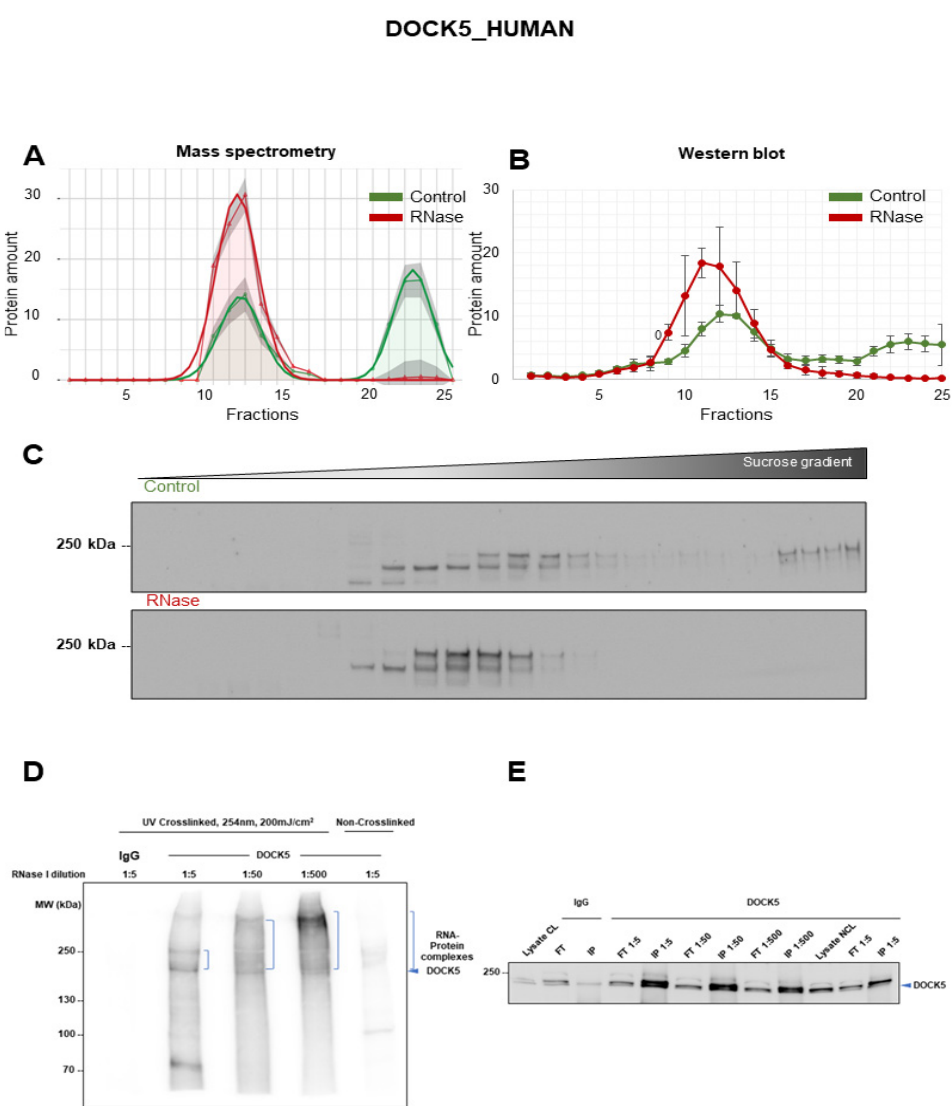
Figure 4. RNA dependence of DOCK5. ( A ) Graphical representation of protein amounts determined by mass spectrometry in all 25 fractions. The experiments were repeated in three replicates. Mean of the raw data (total protein amount normalized to 100) is indicated by the pointed curve with gray shadows representing the standard deviation while the smooth curve represents the Gaussian fit. ( B ) Graph representing the quantitative analysis of three Western blot replicates showing the mean and SEM across 25 fractions. The green line represents the control gradients, and the red line represents the RNase-treated gradients. The quantified overall protein amount was normalized to 100 to make it comparable to the mass spectrometry analysis. ( C ) Western blot image of DOCK5 (215 kDa) in A549 gradients treated − /+ RNase. ( D ) Autoradiography showing the direct RNA binding of DOCK5 by iCLIP2 indicated by shifting of the radioactive signal toward higher molecular weights with decreasing RNase I concentrations ( n = 3). ( E ) Western blot confirming immunoprecipitation of DOCK5 (n = 3). Original blots: see File S1.